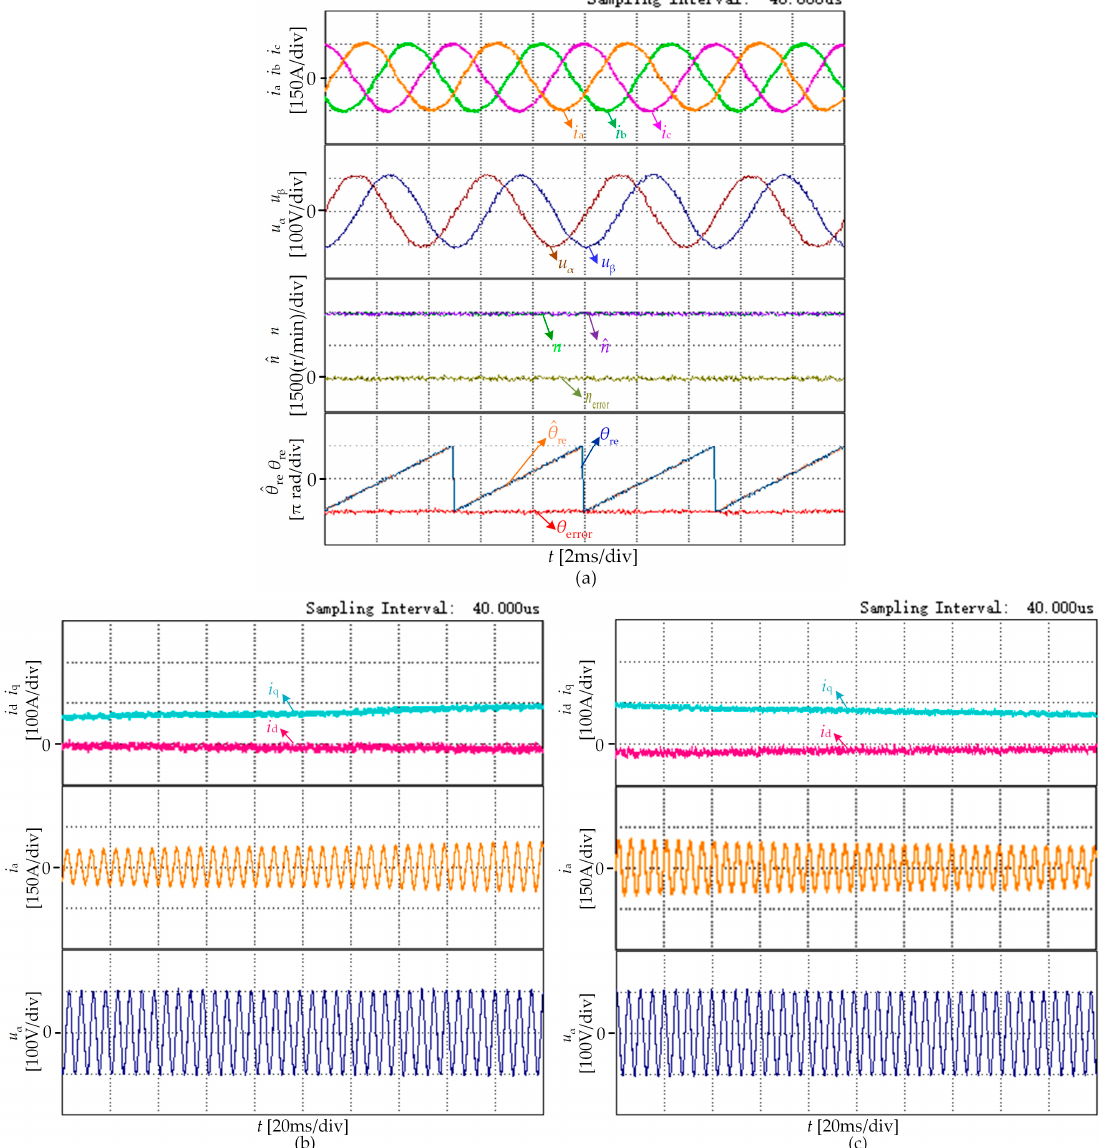
Figure 7. The enlarged experimental waveforms in Figure 6: ( a ) Steady state, ( b ) increase load, ( c ) decrease load.